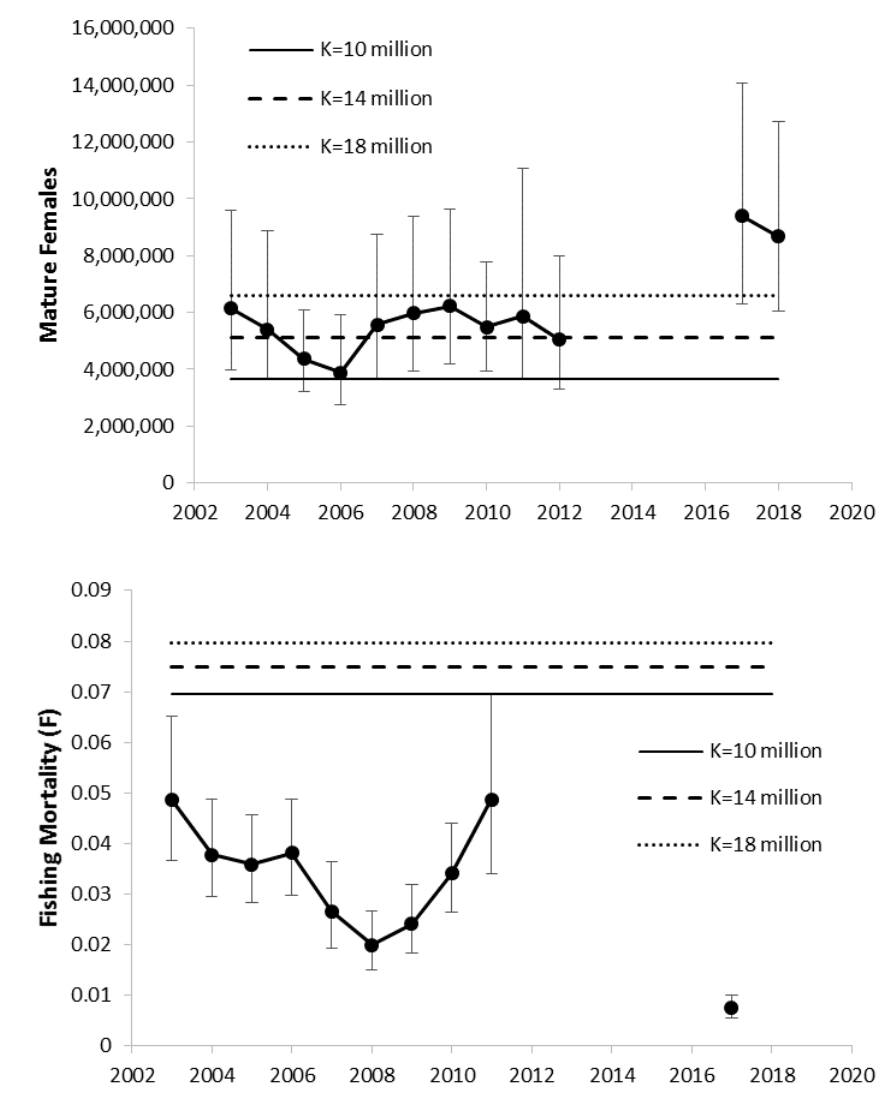
overfishing is not occurring. The horizontal lines on the graphs indicate the